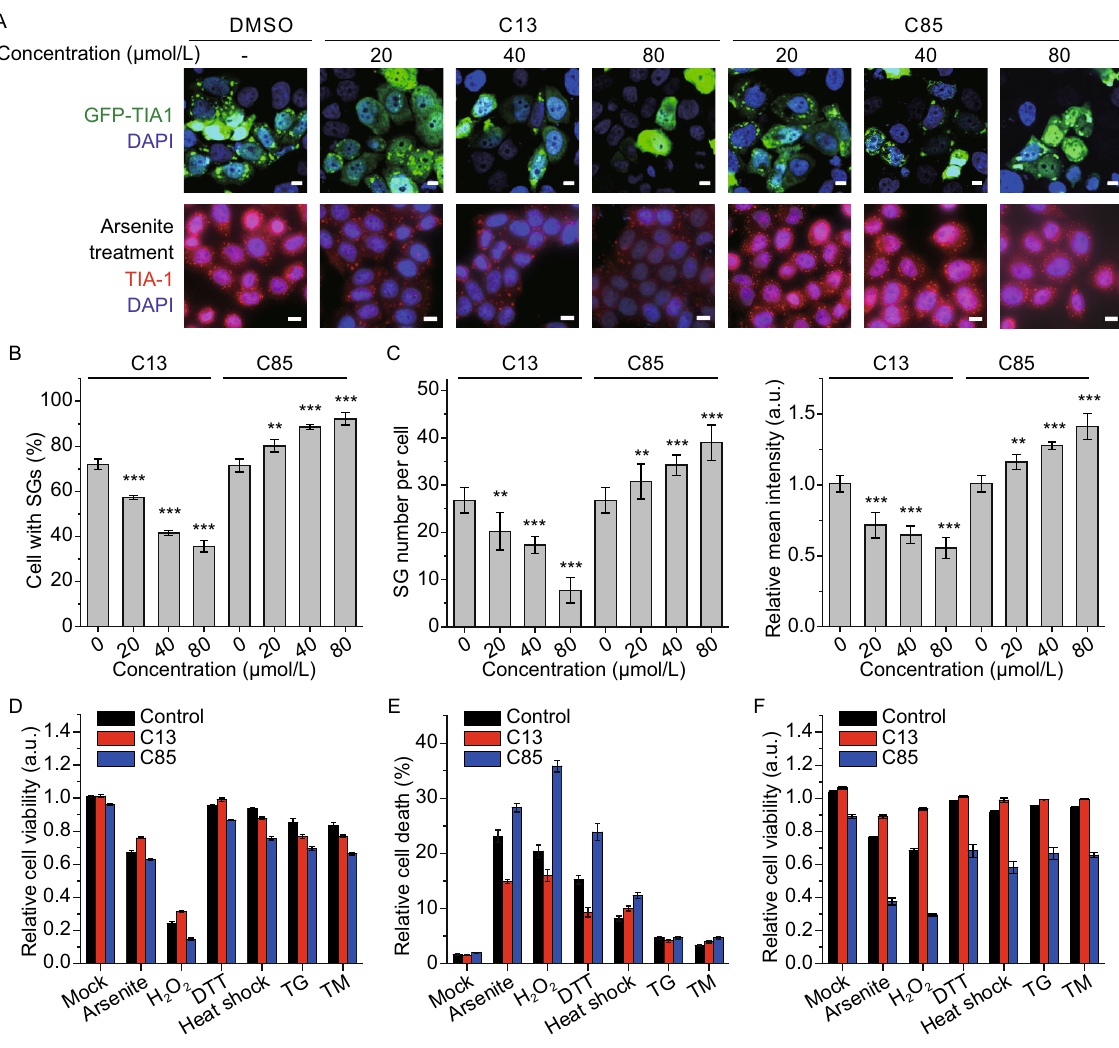
Figure 2. Veri fi cation of the action of C13 and C85 on SGs in HeLa cells . (A) Representative confocal microscope images showing the effects of various concentrations of C13 and C85 on SGs in HeLa cells induced by overexpression of GFP-TIA-1 or 0.5 mmol/L arsenite for 30 min. Scare bar, 10 μ m. Treatment of C13 or C85 did not affect the transient transfection ef fi ciency or expression level of TIA-1 as evaluated by fl uorescence mean intensity and Western-blot analysis (data not shown). (B) Quantitative analysis of the actions of C13 and C85 on GFP-TIA-1 overexpression-induced SGs in HeLa cells. The percentages of cells with SGs were calculated from 10 randomly selected viewing fi elds. (C) Quantitative analysis of the effects of C13 and C85 on the number of SGs per cell and mean fl uorescence intensity. SGs were induced by 0.5 mmol/L arsenite for 30 min. ** P < 0.01, *** P < 0.001. (D) Effect of the two compounds on cell survival when the HeLa cells were treated by various stressors. Cell viability was measured immediately after the stress treatment to re fl ect the sensitivity of stress response. (E) Cell death determined by fl ow cytometry analysis for samples double stained using annexin V and propidium iodide. (F) Effect of the two compounds on the recovery of the HeLa cells from stressed conditions. The cell viability was measured by refreshing the culture medium to remove the stressors and cultivated for 2 h. All cell viability data are presented as mean ± S.E.M. ( n =